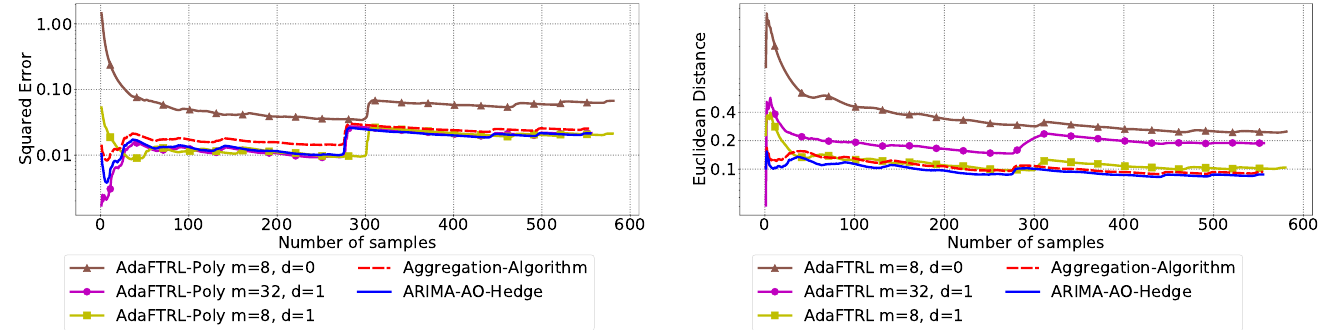
Figure 11. Model selection for Google Flu.